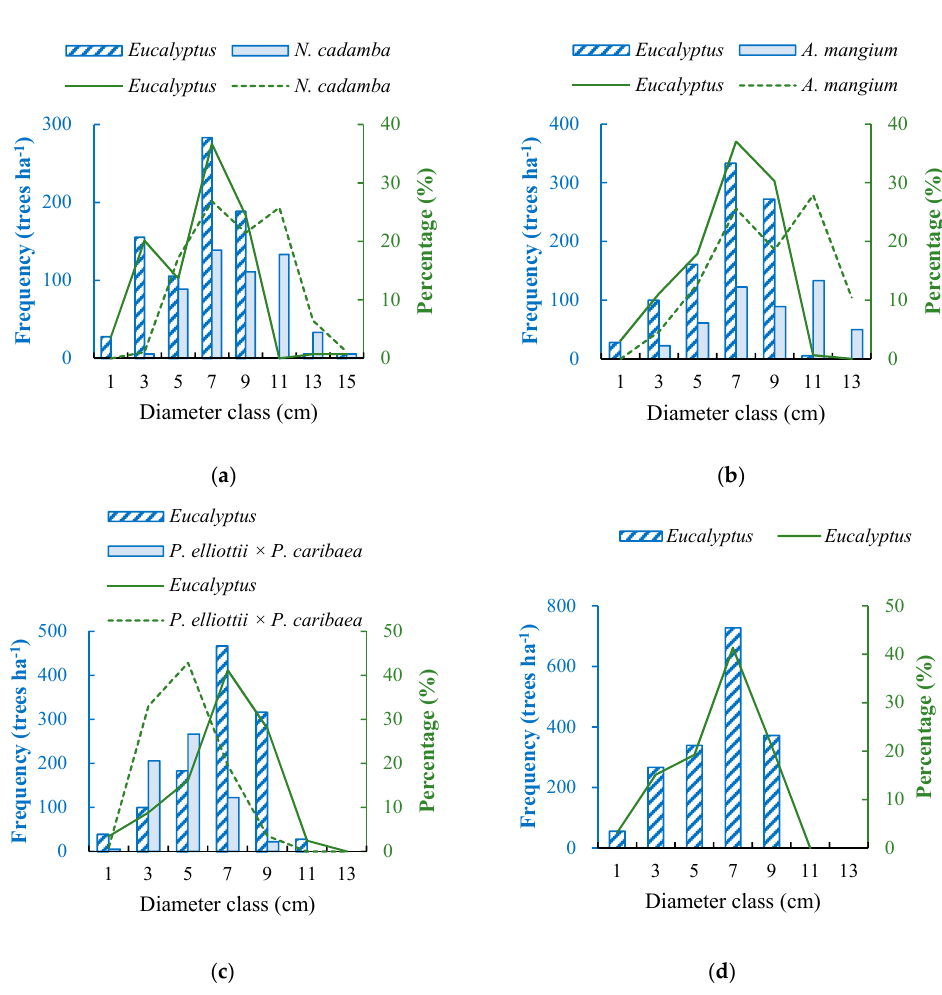
Figure 5. Diameter distribution of E. urophylla × E. grandis at the age of 18 months and of mixed tree species at the age of 38 months in the monoculture and mixtures. Height of the histograms shows the distribution frequency of diameter of each tree species per hectare. The line shows the distribution percentage of diameter of each tree species per hectare. ( a ) Mixed plantation of Eucalyptus and N. cadamba (EN); ( b ) mixed plantation of Eucalyptus and A. mangium (EA); ( c ) mixed plantation of Eucalyptus and P. elliottii × P. caribaea (EP); ( d ) pure forest of E. urophylla × E. grandis (EE).